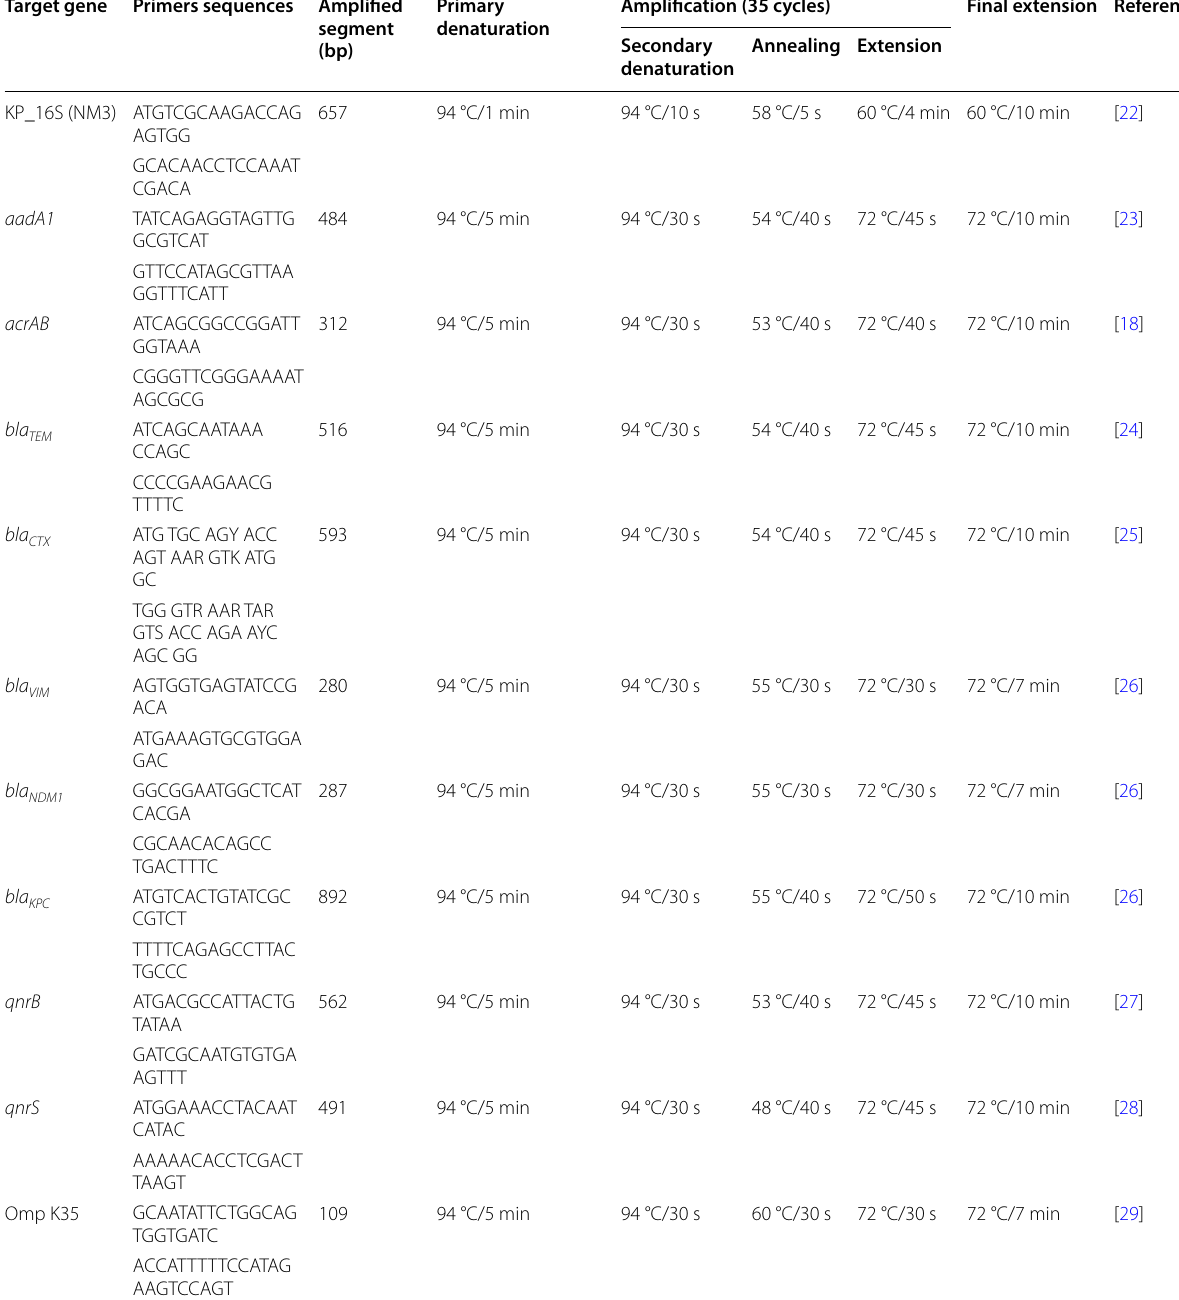
Table 1 Primers sequences, target genes, amplicon sizes and cycling conditions Target